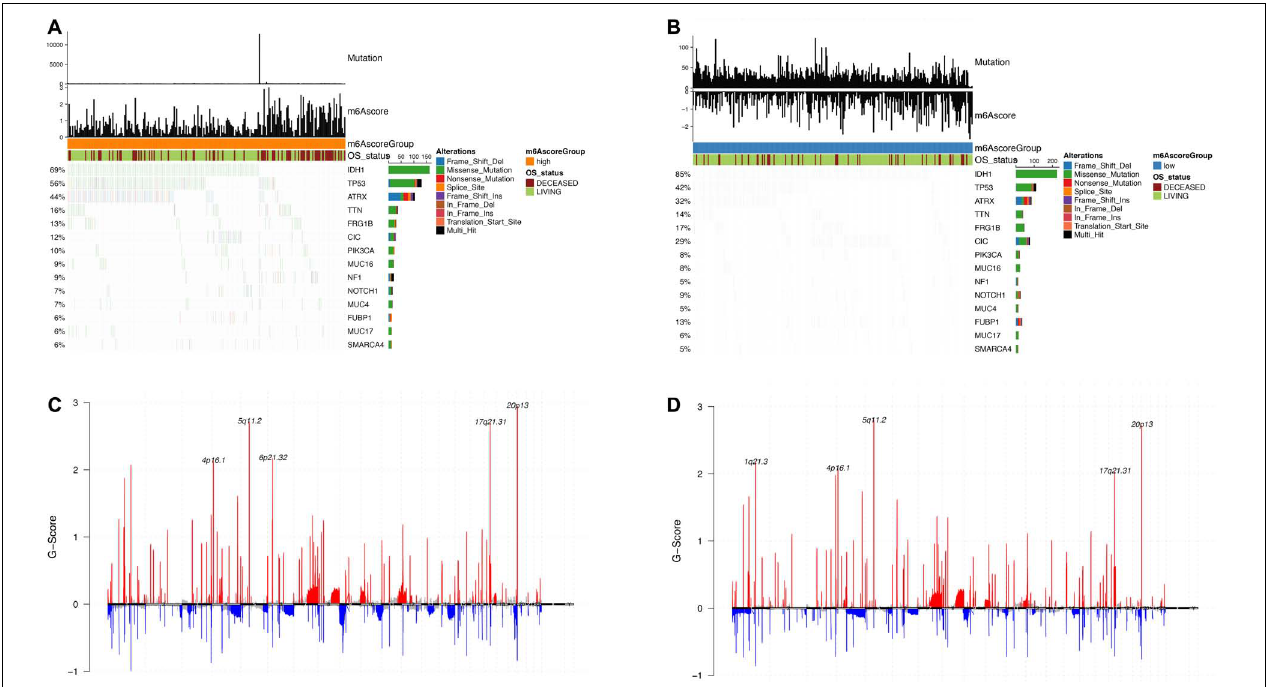
FIGURE 8 | Analysis of molecular characteristics of m6Ascore high and low groups. (A,B) Distribution of gene mutations in samples of m6Ascore high and low groups; (C,D) The distribution of copy number amplification and deletion regions in the sample set of m6Ascore high and low